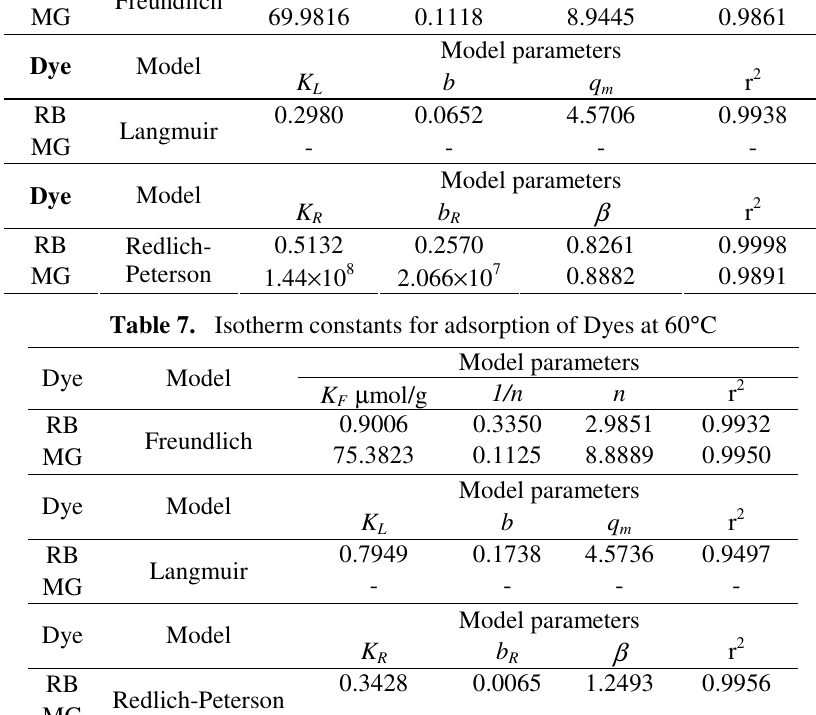
Model parameters